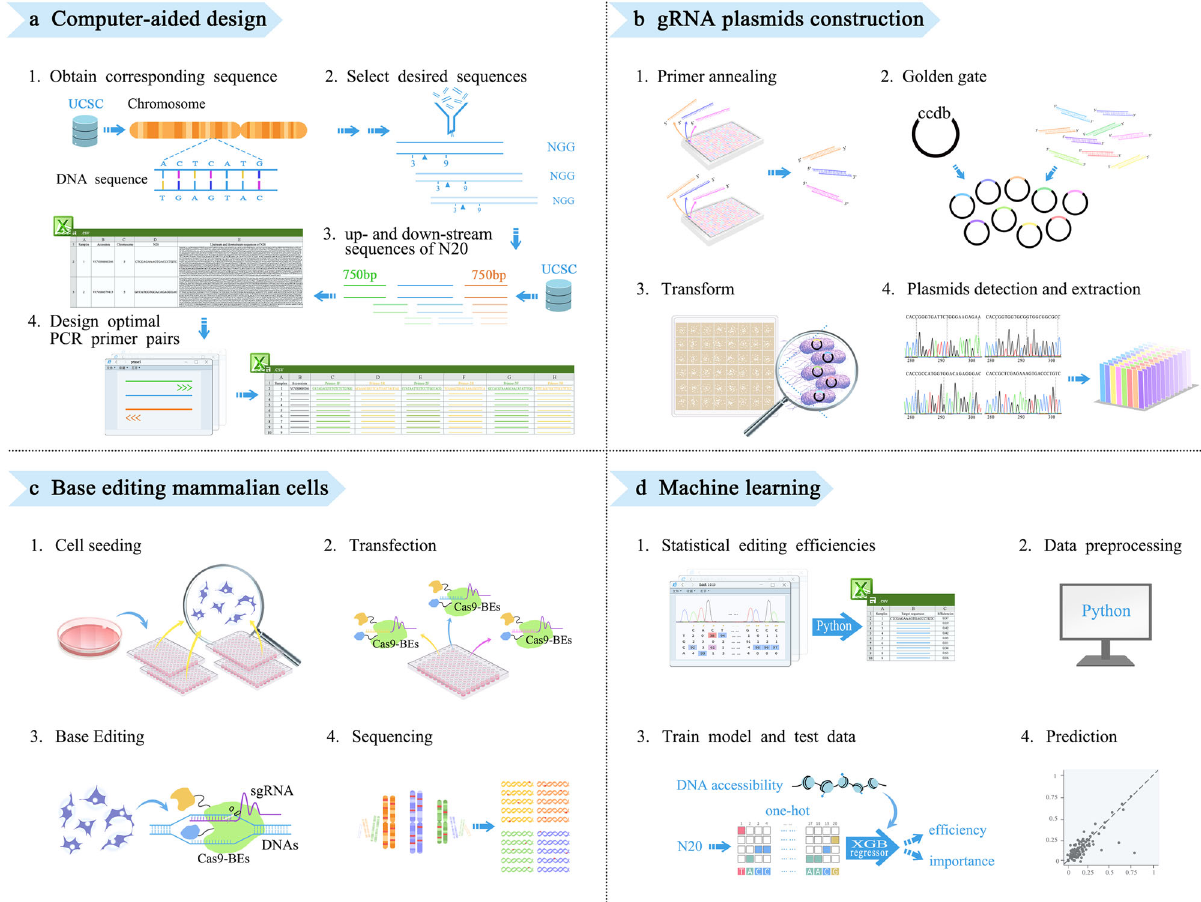
Fig.1|Overviewofautomatedhigh-throughputplatformofgeneeditinginmammaliancells.a Machinedesignmodule,gRNAplasmidsdesignandbatchedprimers acquisition. b gRNA plasmids construction module. c Cellular base editing module. d Machine learning of the in situ editing